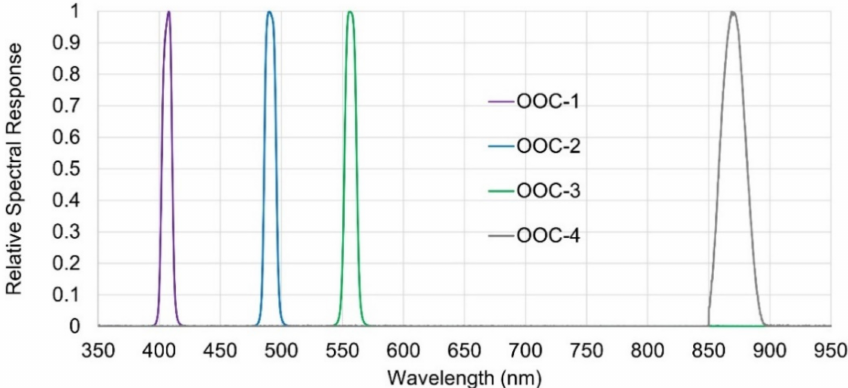
Figure 2. Relative spectral response functions of the